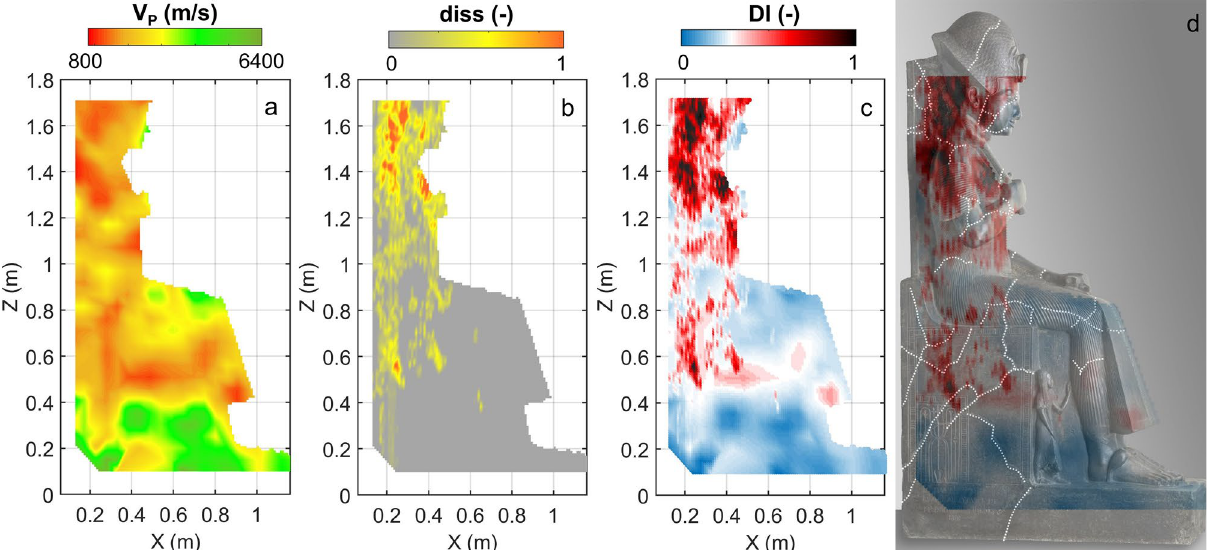
Figure 8. ( a ) Ultrasonic velocity, ( b ) local dissimilarity (L11 scan), ( c – d ) damage index on the axial vertical section of the statue of Ramses II. In ( d ) superficial fracture traces are highlighted on the image of the statue by white dashed lines. Figure created in Matlab (version R2021b, https:// it. mathw orks. com/ produ cts/ matlab.